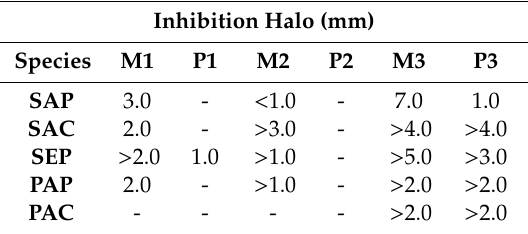
Table 4. Antimicrobial activities of M1, M2 and M3 vs. P1, P2 and P3, using the disk di ff usion